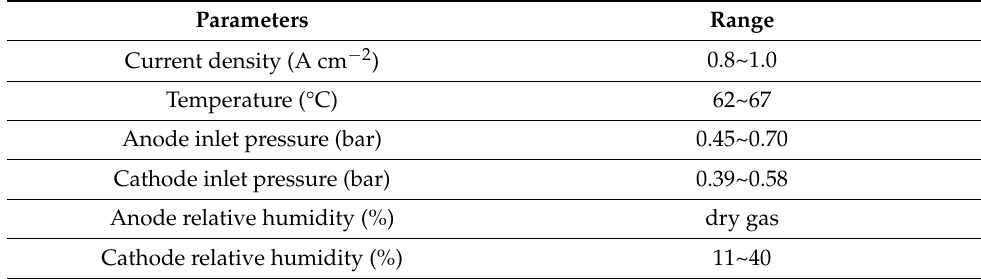
Table 2. Operation parameters during the aging